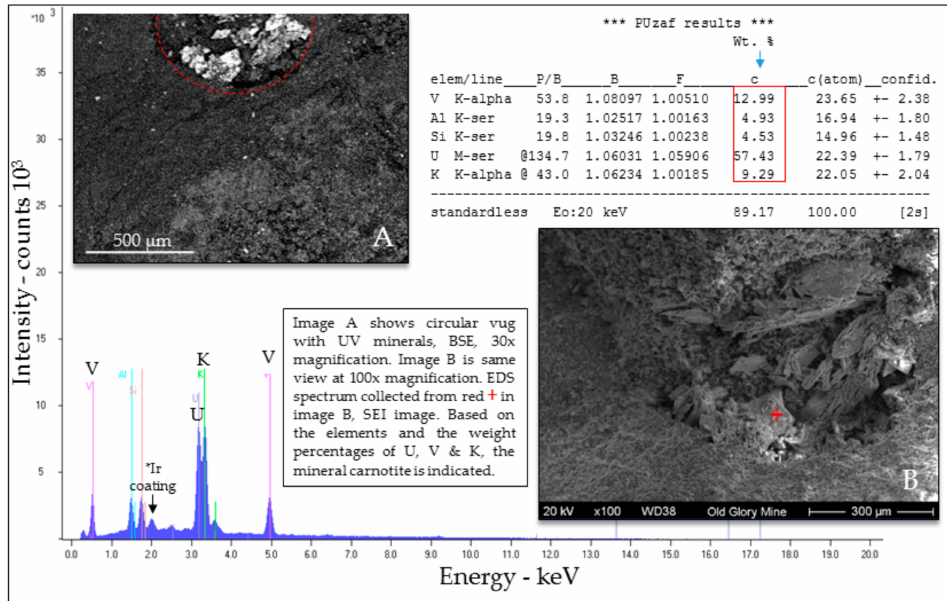
Figure A2. Image A in figure shows Old Glory mine silicified breccia sample with U-V minerals in a vug. Image B is a higher magnification of Image A. The EDS spectrum was collected from + in Image B. Carnotite is indicated based on the empirical formula K 2 (UO 2 ) 2 (VO 4 ) 2 · 3(H 2 O) which has the weight percentage for elements K (8.67%) V (11.29%) U (59.86%) [113] outlined in red in the PUzaf results. Sample was coated with Ir. The Ir peak is denoted by the *Ir and arrow. Ir coating was subtracted out before the normalization was performed by the program utilized by the instrument.